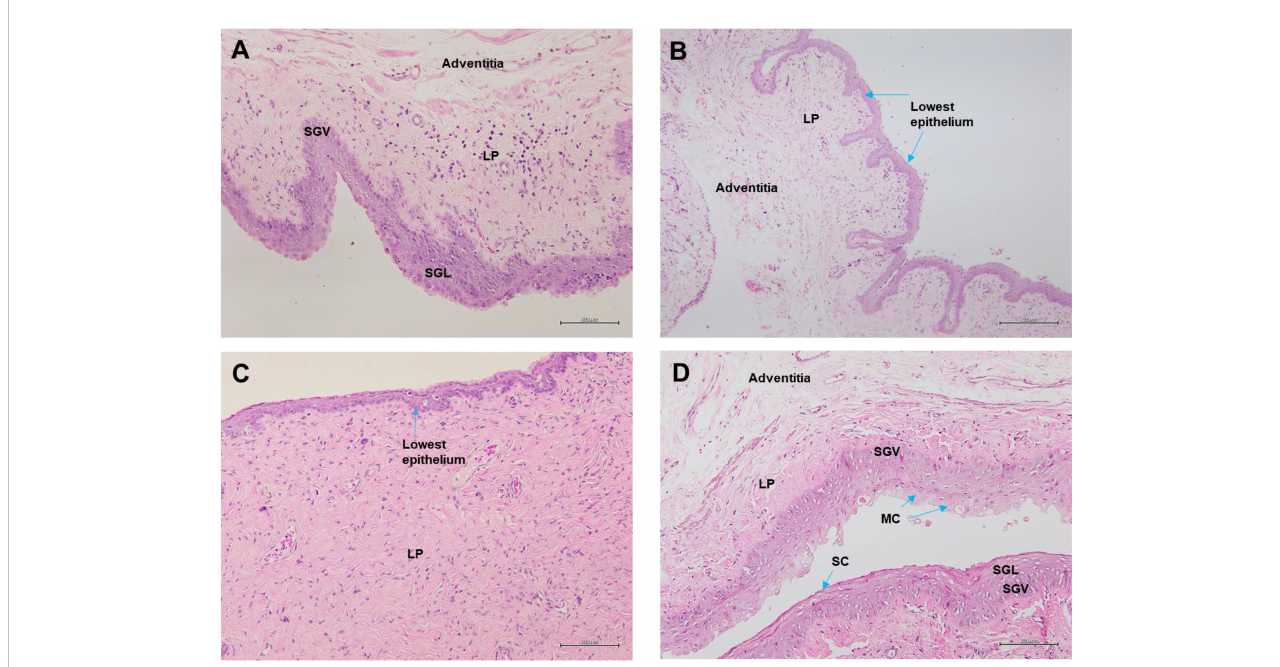
FIGURE 9 Vagina epithelia stained with H&E in (A) Gelam honey and bilateral oophorectomized group (Gelam honey+Ovx), (B) Estrogen replacement therapy and bilateral oophorectomized group (ERT+Ovx), (C) Bilateral oophorectomized group (Ovx) and (D) Sham group (SC). SGV, stratum germinativum layer; SGL, stratum granulosum layer; SM, stratum muci fi cation layer; MC, mucus cells; LP, lamina propia; SC, startum corneum. All measurement bars are equivalent to 100